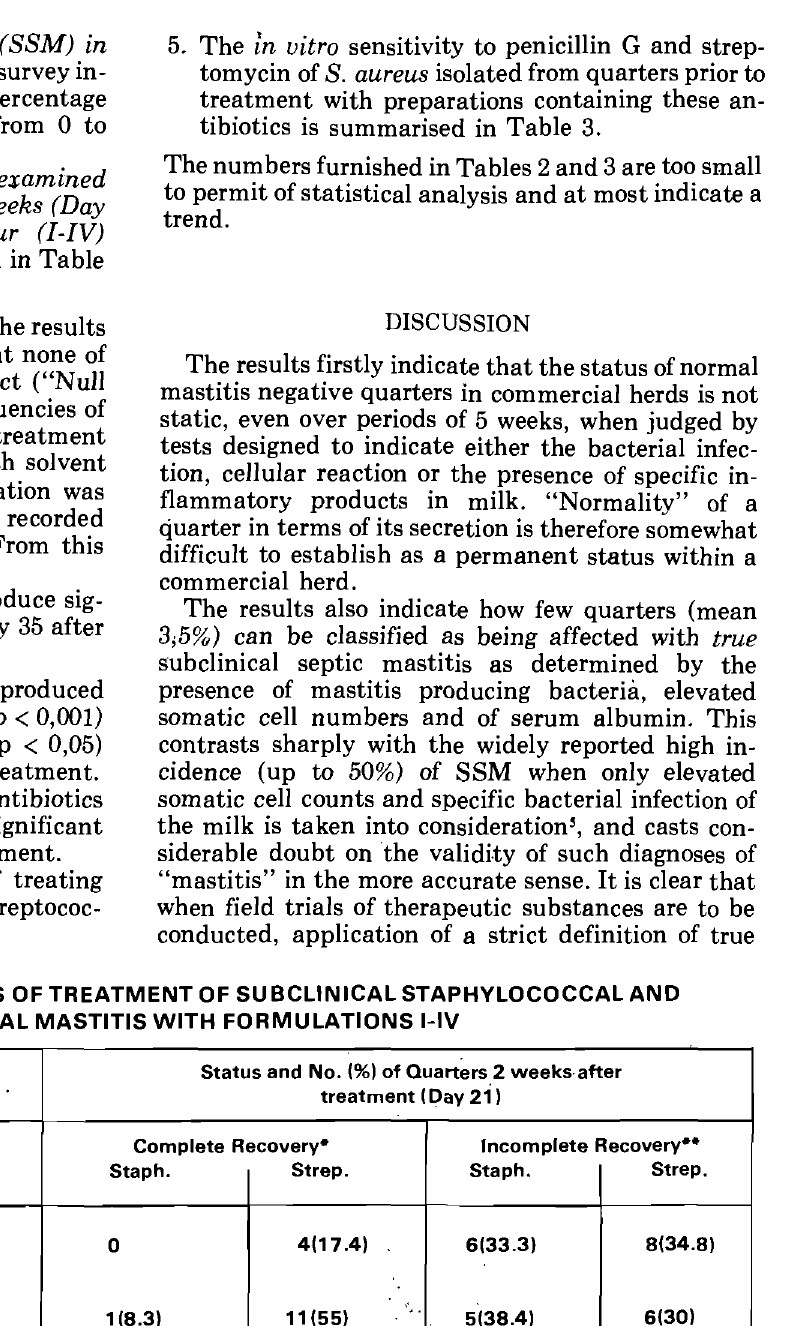
Table 3: IN VITRO SENSITIVITY TO PENICILLIN G AND STREPTOMYCIN OF S. AUREUS ISOLATED FROM CASES OF SUBCLINICAL SEPTIC MASTITIS BEFORE AND AFTER TREATMENT WITH THESE ANTIBIOTICS ON DAY